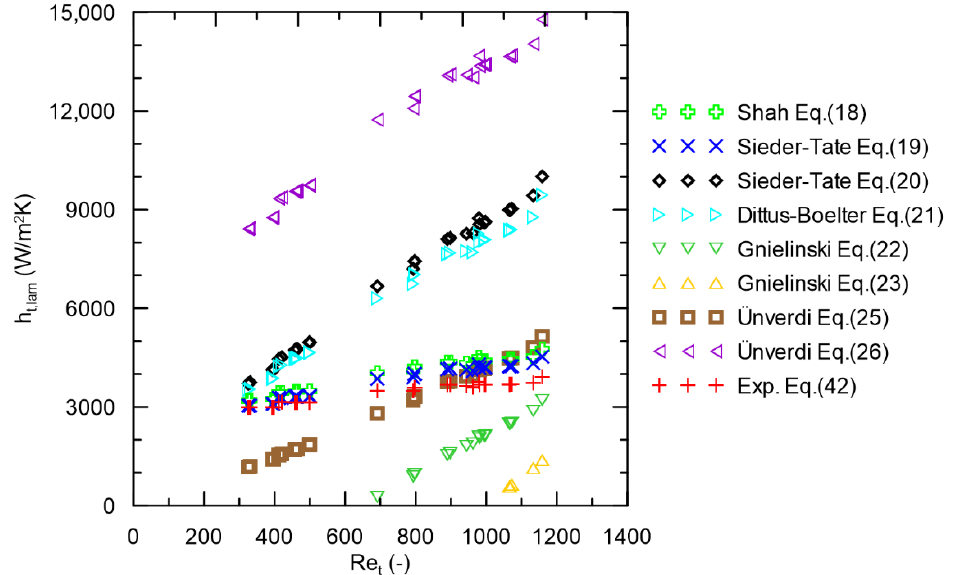
Figure 4. Heat transfer coefficient for the laminar flow inside tubes h t , lam as a function of the tube side Reynolds number Re .